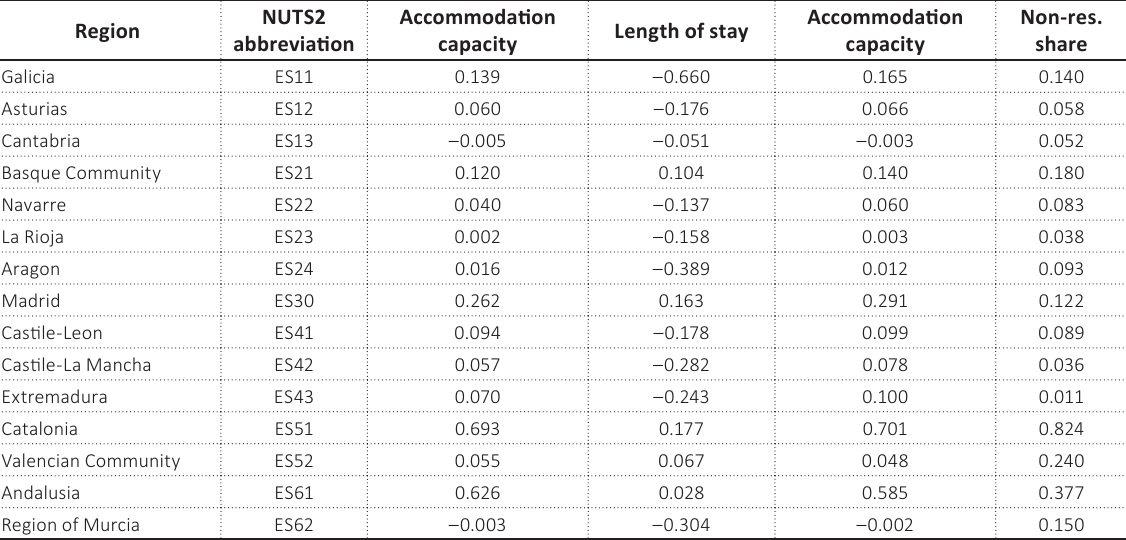
Table 6. Mainland Spain for PLS coefficients of capacity vs. length of stay and non-residents